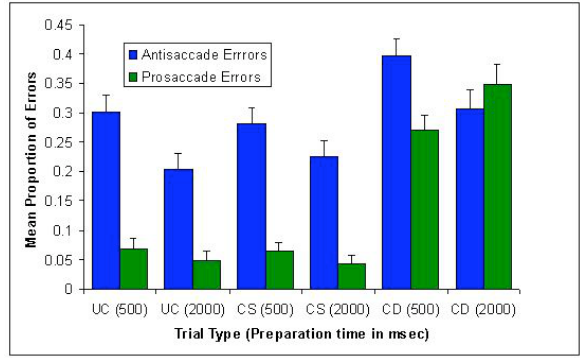
Figure 1. Pro and antisaccade error rates across different trial types.